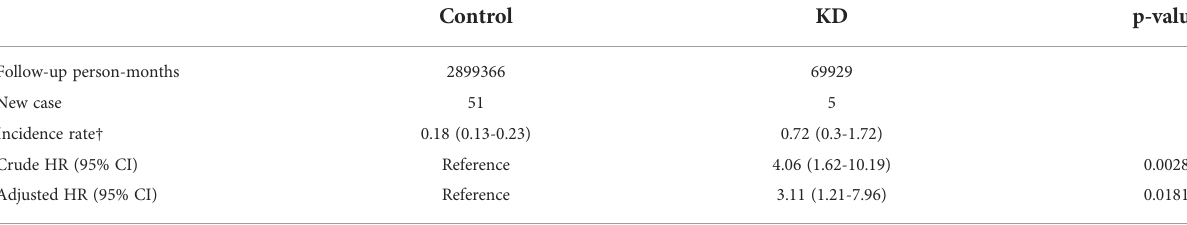
TABLE 5 Sensitivity analysis (de fi nition of KD: catastrophic disease): Incidence of